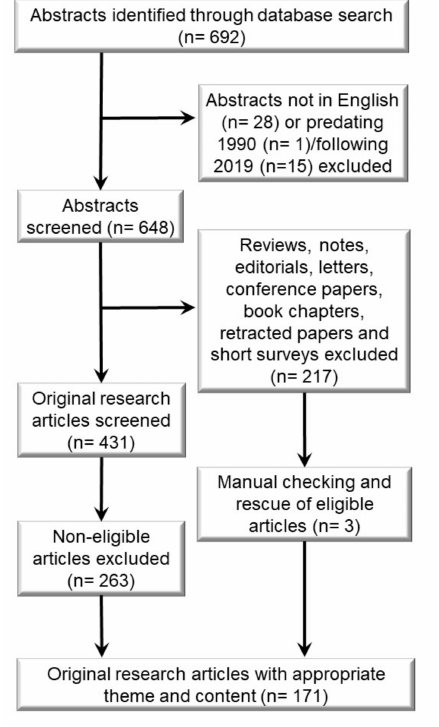
Figure 4. Workflow for literature